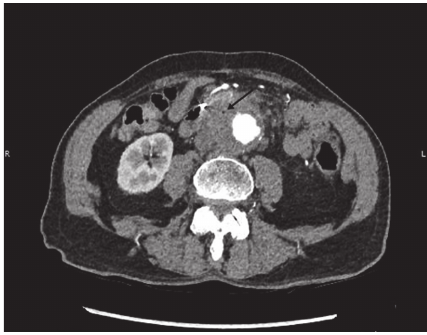
Figure2:CTAshowinga5.3 cmaorticaneurysm,markedsofttissue thickeningoftheaorticwall,andasmallpocketofgaswithinthesoft tissue of the aorta (soft tissue gas designated by the arrow).